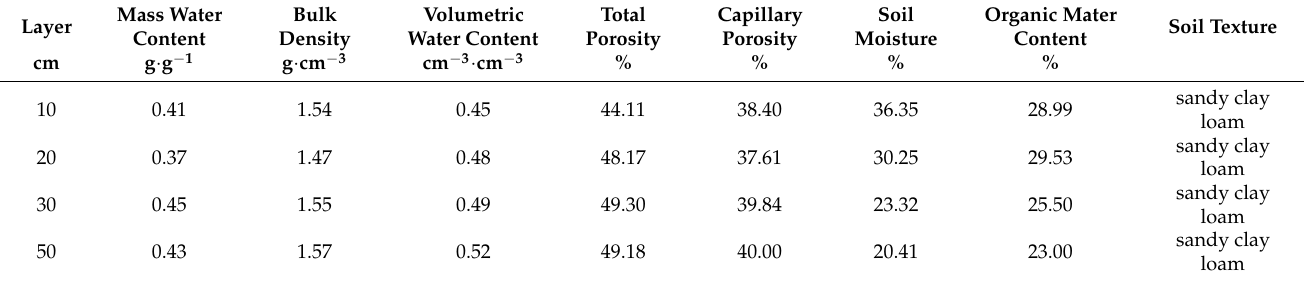
Table 1. Water and physical properties of the studied soil substrate (data from Halecki and Klatka,